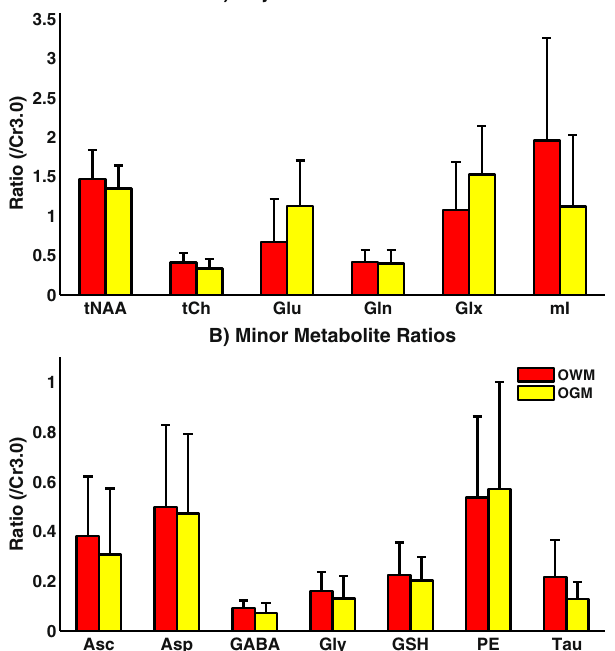
Figure 8. Occipital white matter (red) and gray matter (yellow) voxels were identified and quantified using ProFit for ten healthy adults (mean age = 25 years old). Metabolite ratios with respect to Cr3.0 are displayed for higher concentration ( A ) and lower concentration ( B ) metabolites. Although no significant (p < 0.004) differences were seen between the two spatial regions, expected trends for tNAA, Glx, and mI are